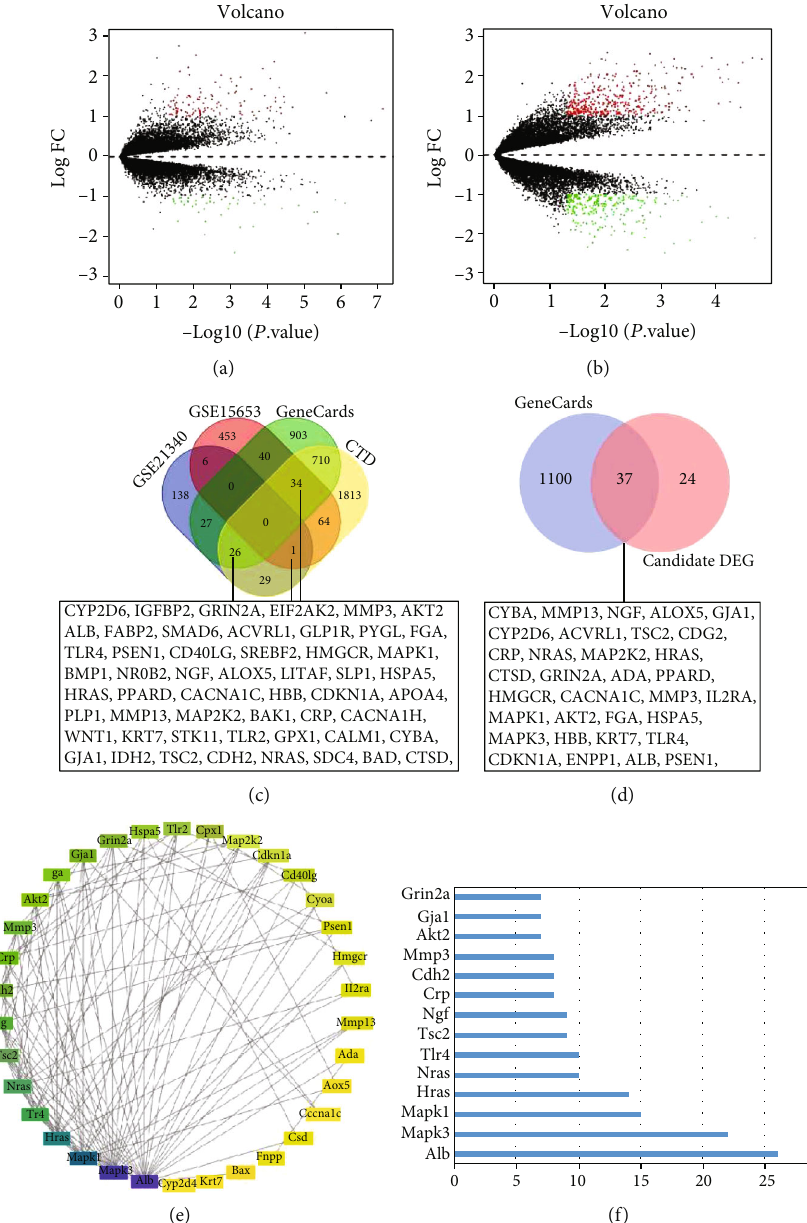
Figure 2: Screening of genes associated with vascular injury in T2DM using datasets in GEO database. (a) Di ff erentially expressed mRNAs in T2DM samples and normal samples from GSE21340 and GSE15653. (b) Di ff erentially expressed mRNAs in T2DM samples and normal samples from GSE15653. Green dots indicated downregulated genes, red dots indicated upregulated genes, and gray dots indicated genes with no signi fi cant di ff erence. (c) Venn diagram of DEGs in GSE21340 and GSE15653 datasets and results from GeneCards and CTD databases. (d) Venn analysis of screening genes in panel (c) and vascular injury-related genes in GeneCards database. (e) Interaction network diagram of the 37 candidate DEGs (nodes represented proteins and edges represented protein-protein associations). (f) The degree value of the candidate